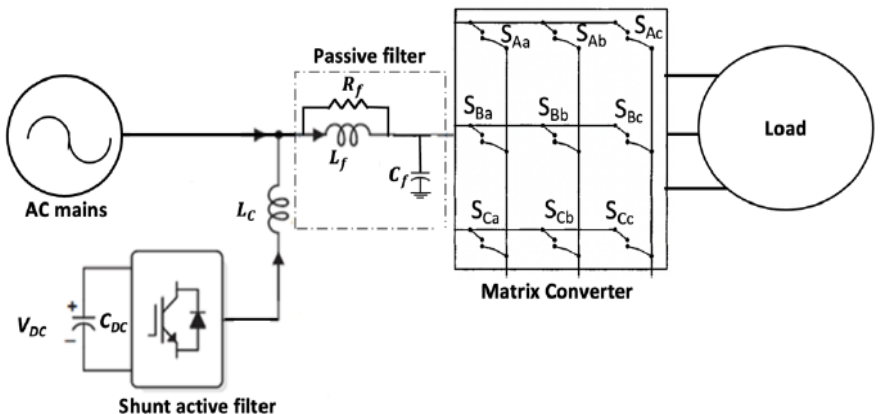
Figure 8. Proposed hybrid active power filter (HPAF) architecture.